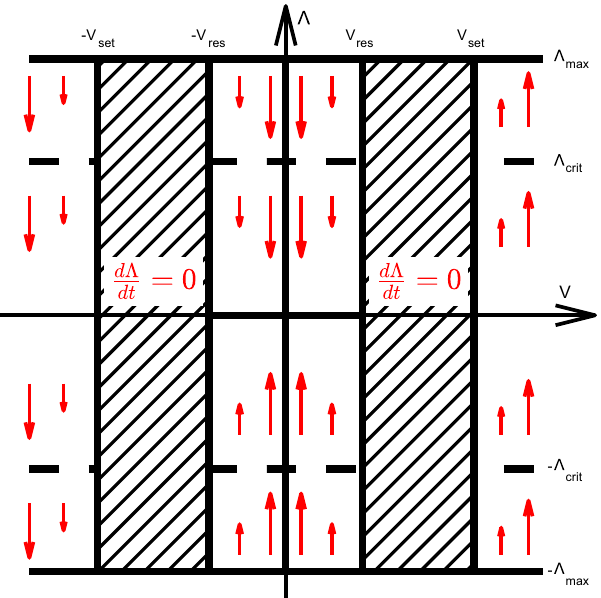
Fig. 9 Pictorial representation of fi lament formation model. Evolution of Λ ( t ) (vertical axis) as a function of junction voltage V jn (horizontal axis) in threshold memristor junction model (Eq. (5)). Arrows are proportional to fi lament growth rate ( d Λ / dt ) and point in the direction of fi lament